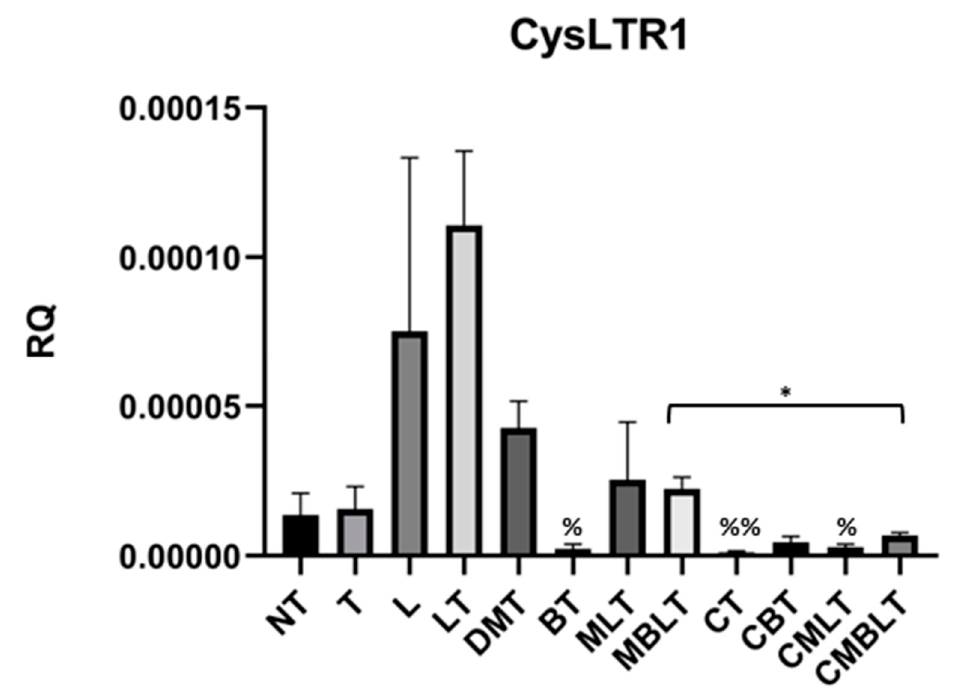
Figure 4. Calcitriol, beclomethasone 17-propionate and montelukast sodium effect on the expression of CysLTR1. mRNA expression CysLTR1 after exposure to calcitriol, beclomethasone 17-propionate, montelukast sodium, LTD4 and TGF- β . The results of experiments (n = 3) are presented in relation to GAPDH as mean ± SEM. Western blots are shown for genes, in which the statistical significance has been observed at the mRNA level. Original Western blots can be found at Figure S1. % p < 0.05, %% p < 0.01 versus LT group; * p < 0.05. One-way analysis of variance (ANOVA) or Kruskal-Wallis test followed by corresponding post hoc was used to determine differences in several groups, and Student’s t -test or Welch’s t -test was used to determine statistically significant differences